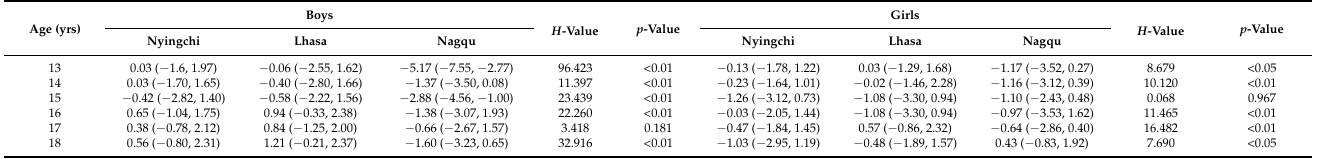
Table 1. Comparison of PFI status of Tibetan children and adolescents of different genders at different altitudes (Median (P25, P75)).